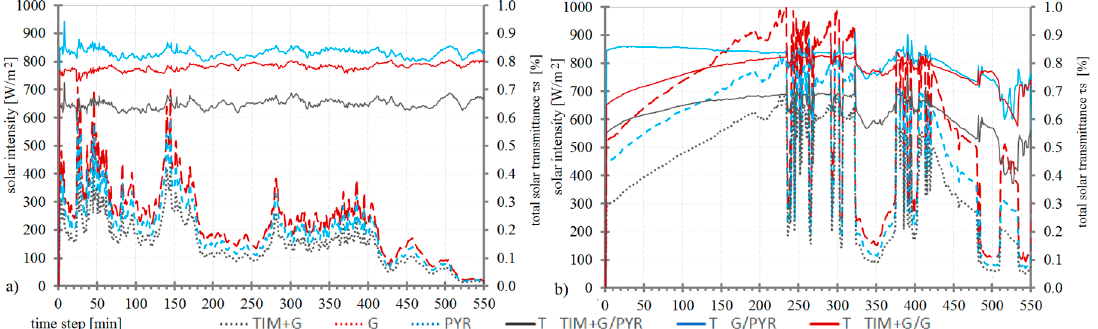
Figure 4. Total solar transmittance results based on outdoor testing; ( a ) overcast; ( b ) almost clear sky, (notes: TIM—transparent insulation material; G—glass pane; PYR—pyranometer; T—total solar transmittance as a ratio of two box configurations). Table 5. Total solar transmittance values τ λ .